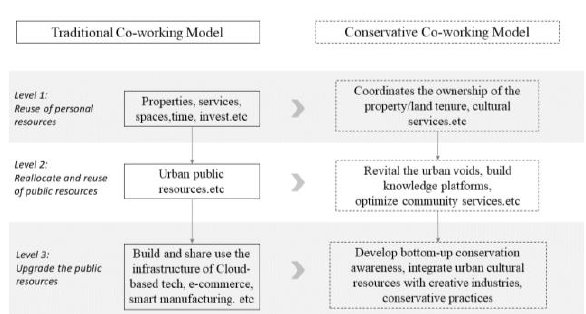
Fig 2. Traditional and conservative coworking model of office industry under sharing economy (resource: Gao,